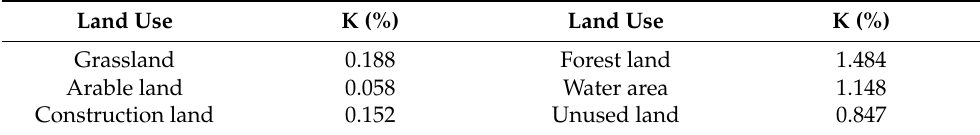
Table 11. The dynamics degree of land use in the study area from 2016 to 2019 (unit: